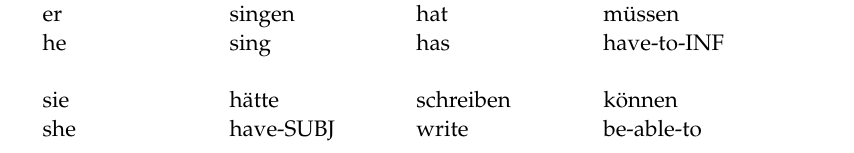
Figure 13. Elementary trees for the examples in (8)